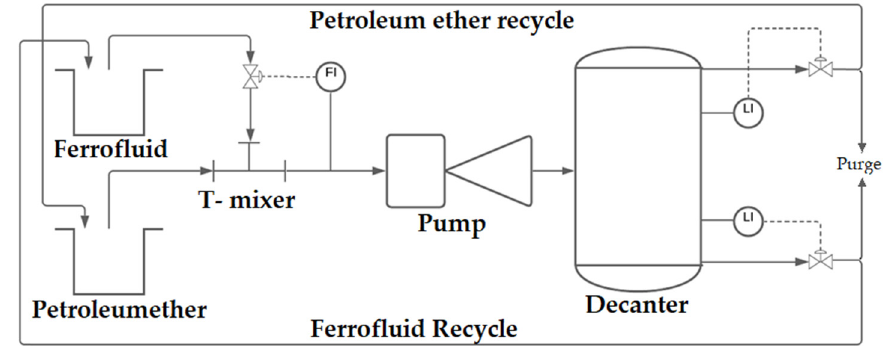
Figure 14. PID flow diagram of the entire process .